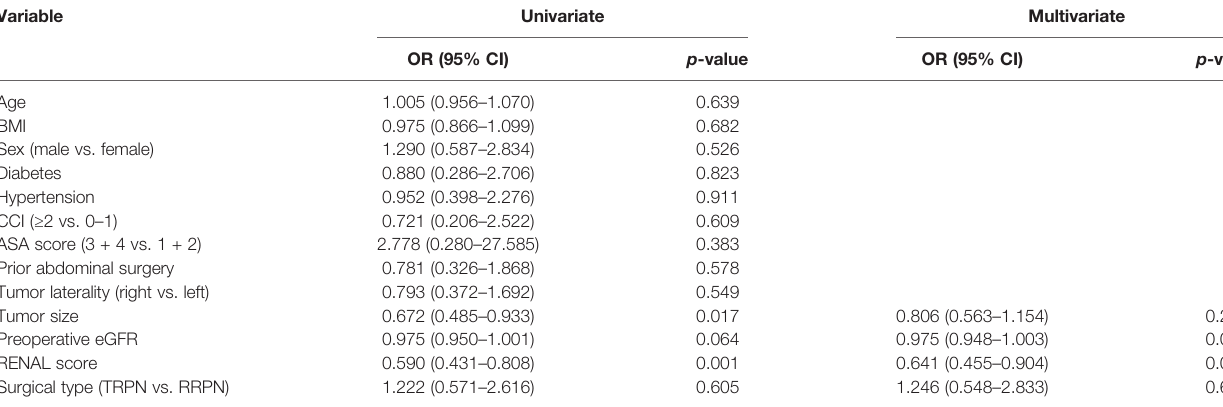
TABLE 5 | Univariable and multivariable analyses for factors associated with achieving pentafecta.